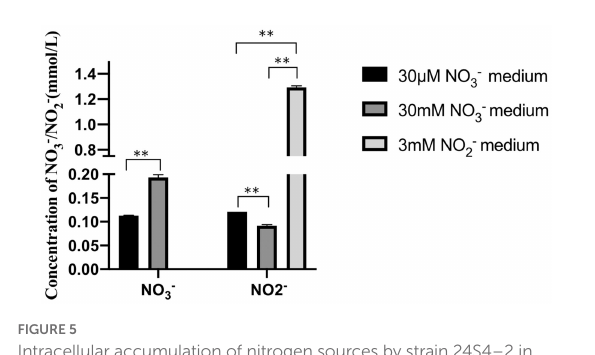
FIGURE 5 Intracellular accumulation of nitrogen sources by strain 24S4–2 in different nitrogen source media. Types and concentrations of intracellularly accumulated nitrogen sources of strain 24S4–2 cultured for 20 d in 30 μ M nitrate medium, 30 mM nitrate medium and 3 mM nitrite medium, “ * ” represents value of p < 0.05, “ ** ” represents value of p < 0.01, and NS: Not Significant.